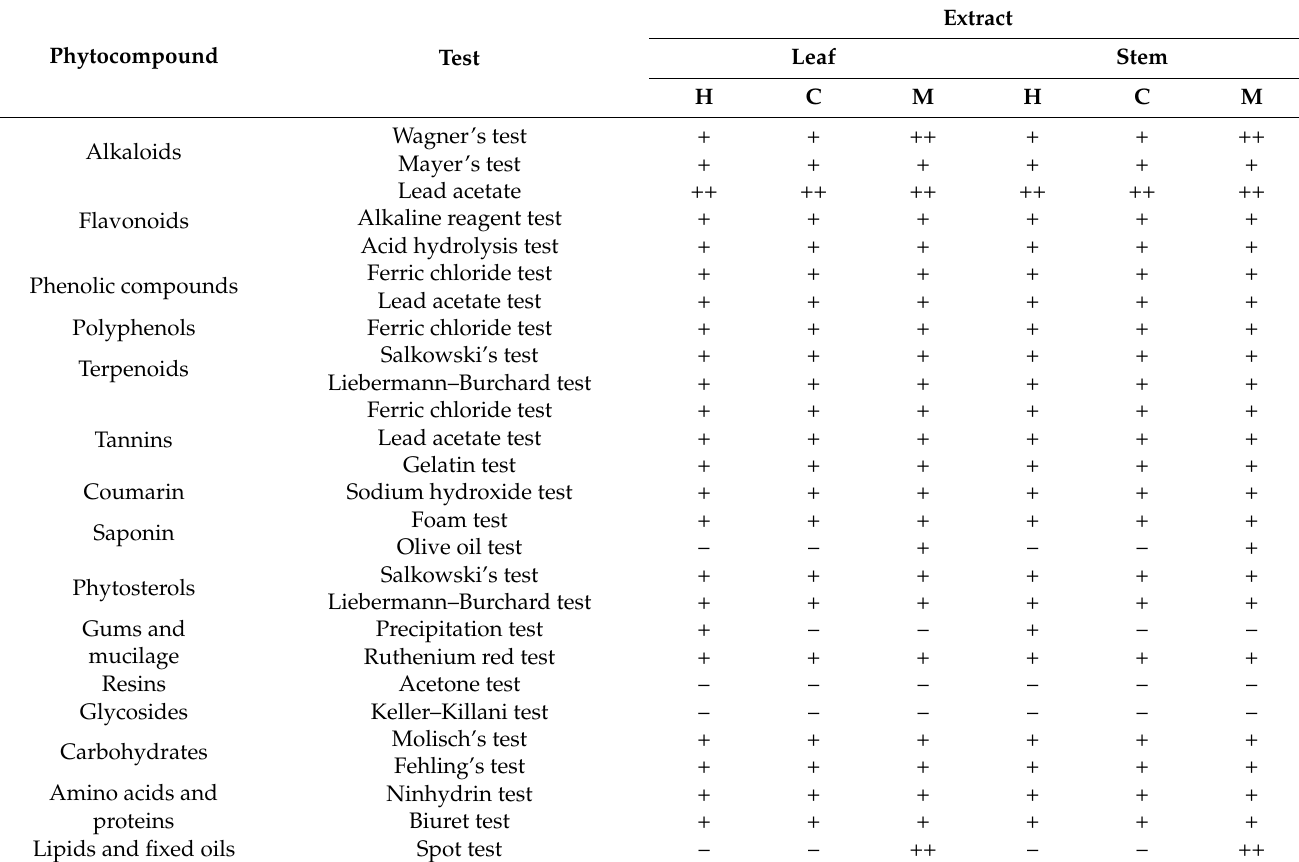
Table 2. Preliminary qualitative phytochemical screening of the hexane, chloroform and methanol leaf and stem extracts of Combretum molle